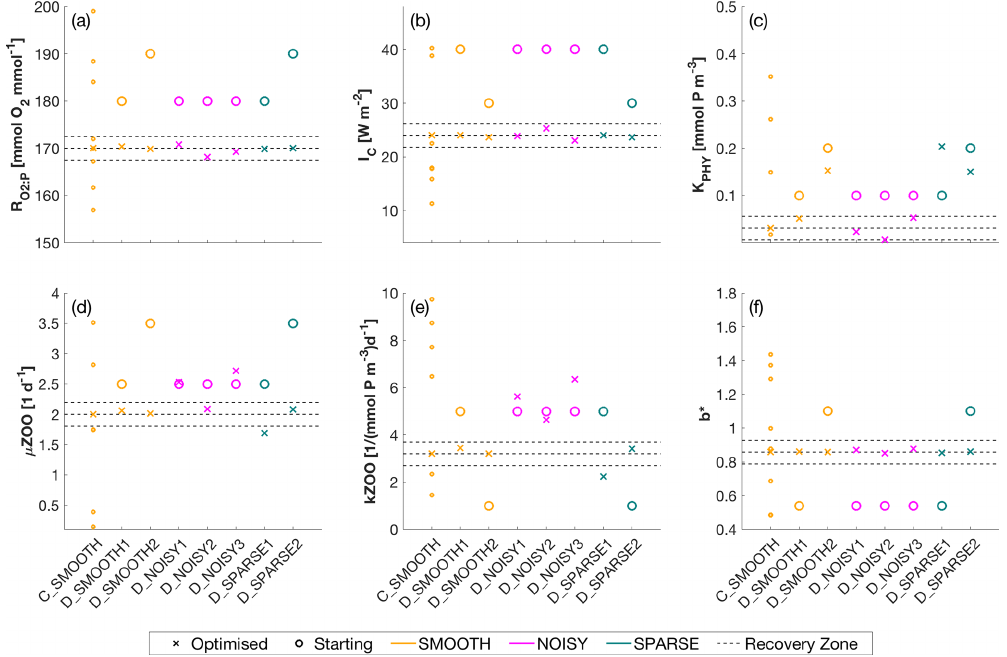
Figure 4. Optimised (cross markers) and starting (circle markers) parameters for all SMOOTH (orange), NOISY (magenta) and SPARSE (green) twin experiments, shown for parameter (a) R O [mmolO 2 : mmolP], (b) I C [Wm − 2 ], (c) K PHY [mmolPm − 3 ], (d) µ ZOO [d − 1 ], 2 : P (e) k ZOO [(mmolPm − 3 ) − 1 d − 1 ] and (f) b ∗ . For C_SMOOTH multiple starting locations (small orange markers) are shown, as unlike DFO- LS, CMAES selects 10 unconstrained randomised starting points. As CMA-ES is unconstrained, not all starting locations plot within the parameter bounds, to which the y -axis limits are fixed. Also plotted are the MOPS-ref target parameter values and ± 5% recovery zone (horizontal black dashed lines). For further information see Table